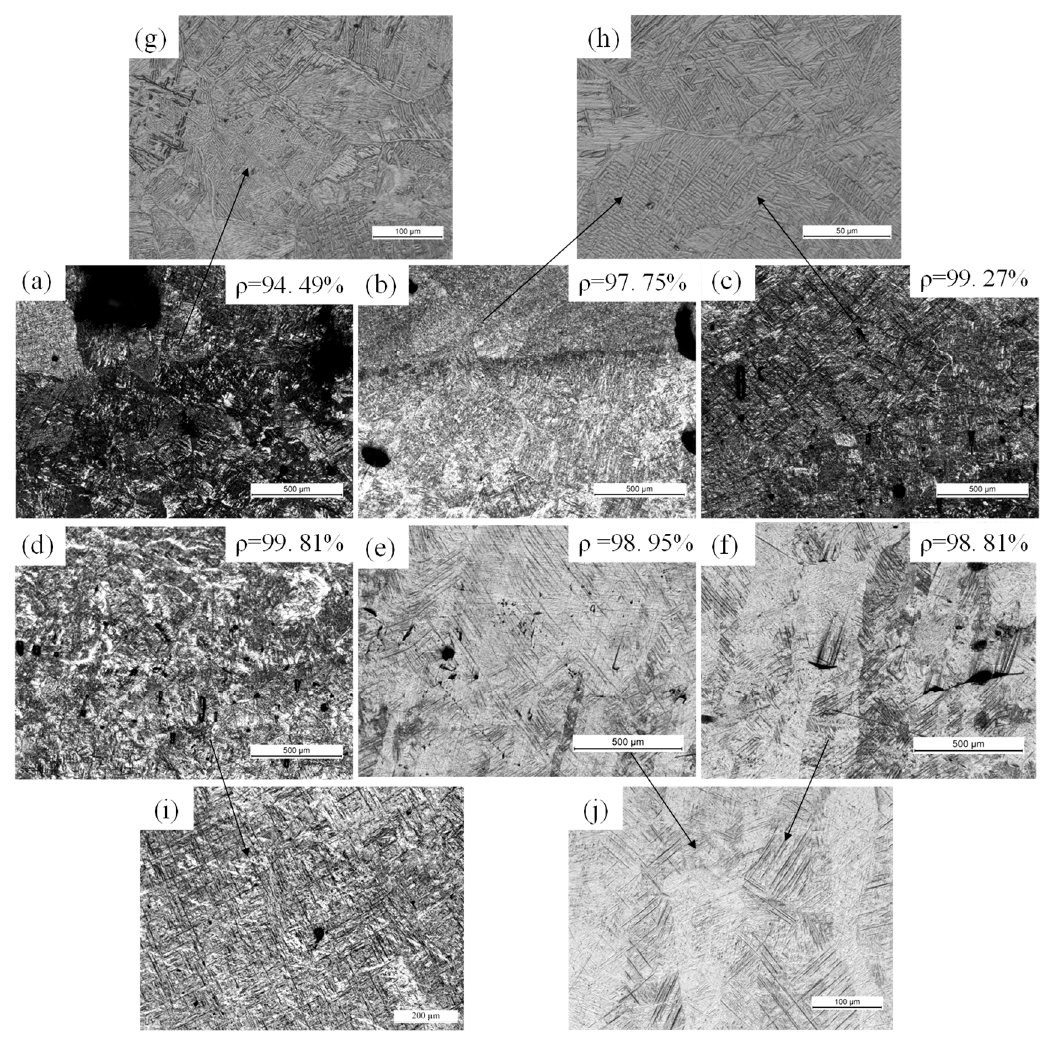
Figure 9. Microstructure and density of selective laser melting (SLM) Ti-6Al-4V samples made at different scanning speeds and hatch spacings using the 50-µm-diameter laser beam. ( a ) v = 25 mm/s; ( b ) v = 50 mm/s; ( c ) v = 75 mm/s; ( d ) v = 100 mm/s; ( e ) v = 125 mm/s; ( f ) v = 150 mm/s. High-magnification optical micrographs showing the ( g , h ) Widmanstätten and ( i , j ) martensite microstructures.